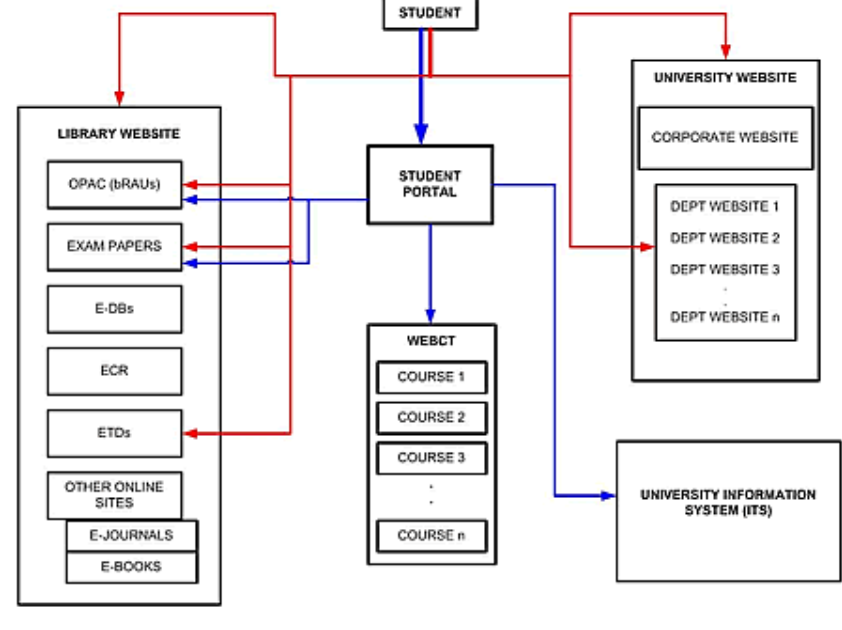
Figure 1 Visual layout of information sources available in the student online